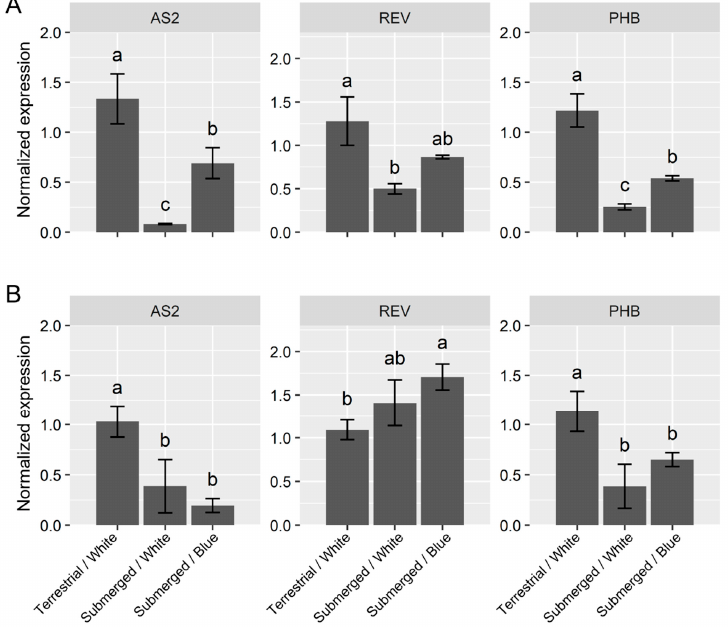
Figure 3. Expression profiles of the adaxialization genes after submergence. The plots indicate the relative expression normalized by ubiquitin5 (mean ± SE, n = 3) after 1 day ( A ) and 7 days treatment ( B ). The different letters denote significant differences among the experimental conditions (Tukey– Kramer test; the adjusted p -value < 0.05). The expression of the abaxialization-related genes YABBY1 ( YAB1 ) and KANDAI2 ( KAN2 ) was repressed by one day of submergence; this was similar to the adaxialization genes under the white-light conditions (Figure 4A). However, KAN3 exhibited a different response to submergence. Its expression was upregulated under the submerged condi- tions. Although each abaxialization gene showed different response patterns to submerg- ence, blue light canceled the effect of submergence. Under blue light, their expression lev- els were similar to those under terrestrial conditions. Seven days of submergence sup- pressed YAB and promoted KAN3 similar to that under one day of submergence; in addi- tion, blue light tended to suppress this effect (Figure 4B). KAN2 showed increased expres- sion after seven days of submergence and increased expression under blue light.